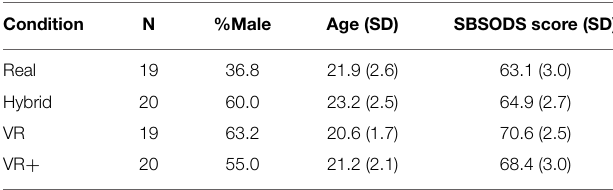
TABLE 1 | Descriptives for all four participant groups.